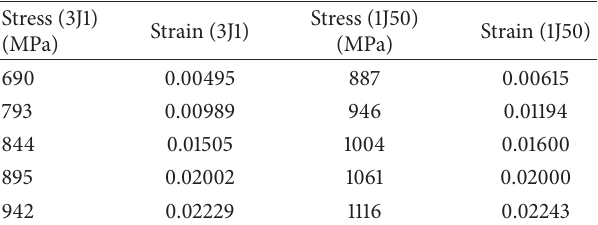
Table 2: Stress-strain laws of materials in plastic zone.